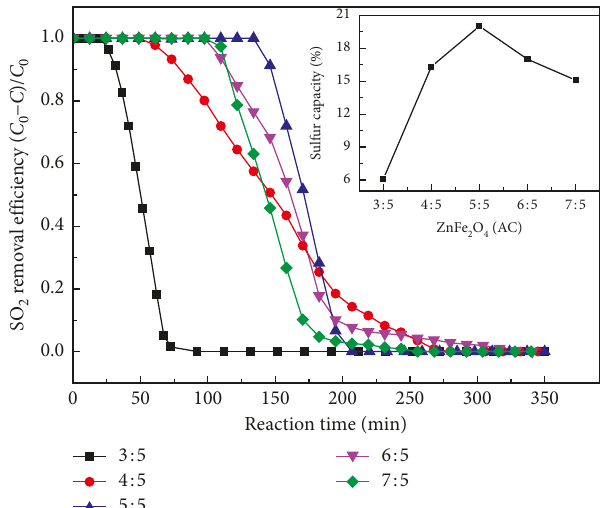
Figure 2: Effect of zinc ferrite/activated carbon at different mass ratios on desufurization